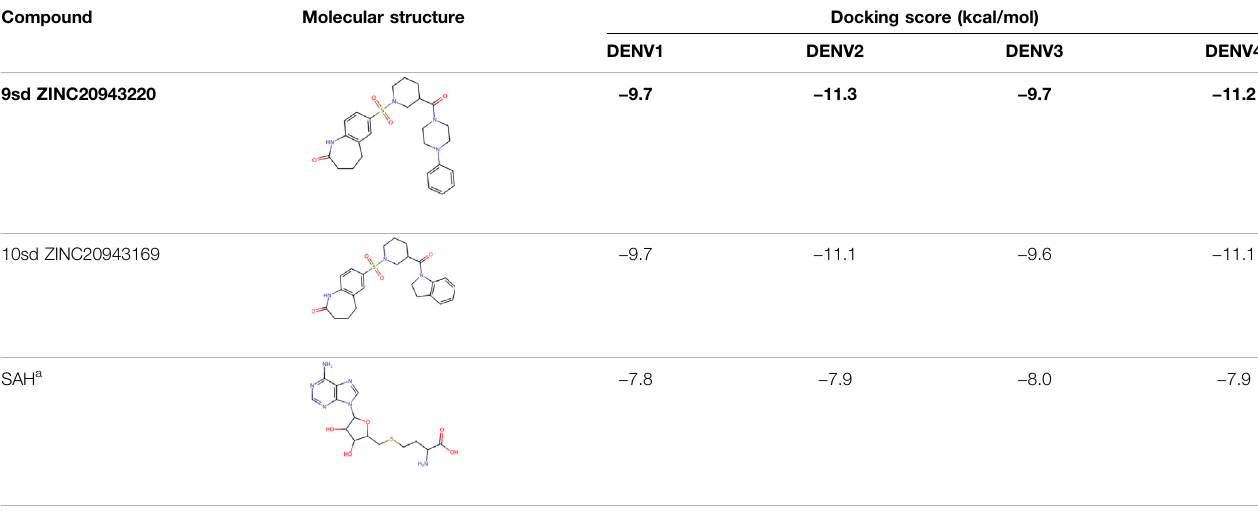
TABLE 4 | Best compounds obtained for the SAM-binding site of the four dengue serotypes. The best compound is highlighted in bold.